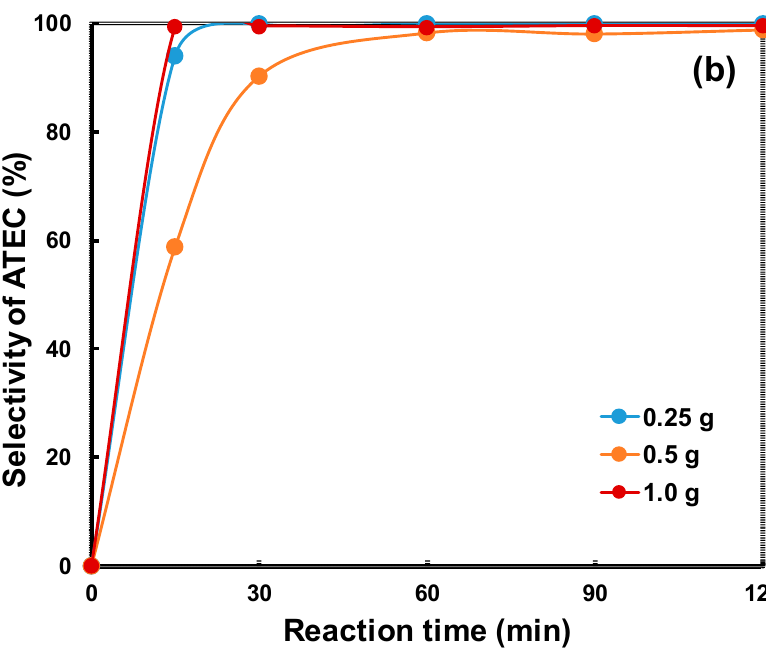
Figure 6. Conversion of TEC ( a ) and selectivity of acetyl triethyl citrate (ATEC) ( b ) in the acetylation over HZ(50) zeolite with different amount of catalyst loading.